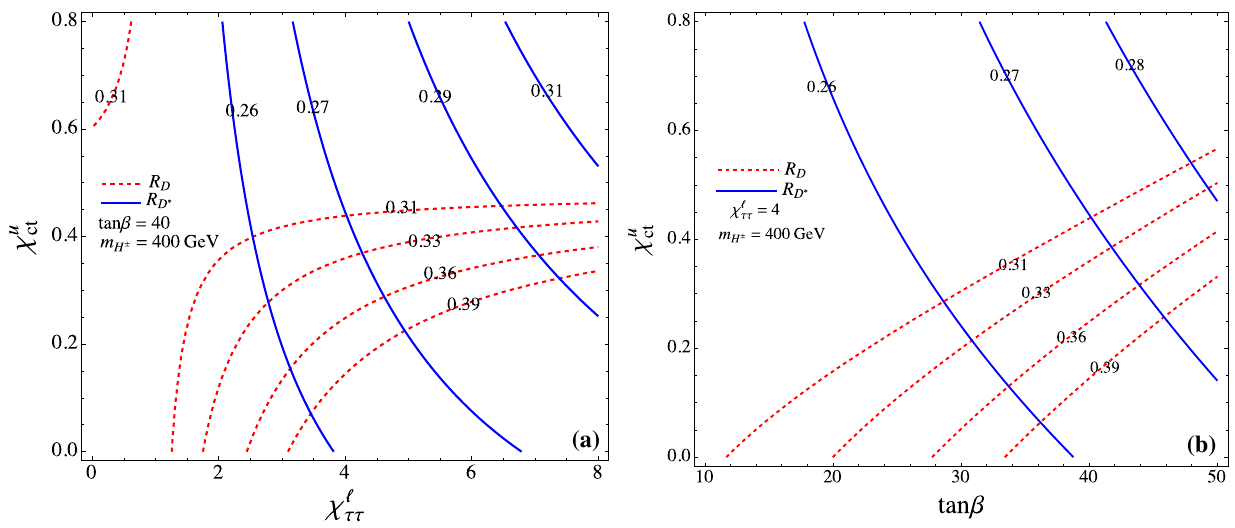
Fig. 1 Contours for R D (dashed) and R D ∗ (solid) as a function of χ u ct and a χ (cid:4) ττ with tan β = 40, b tan β with χ (cid:4) ττ = 4, where we have fixed m H ± = 400